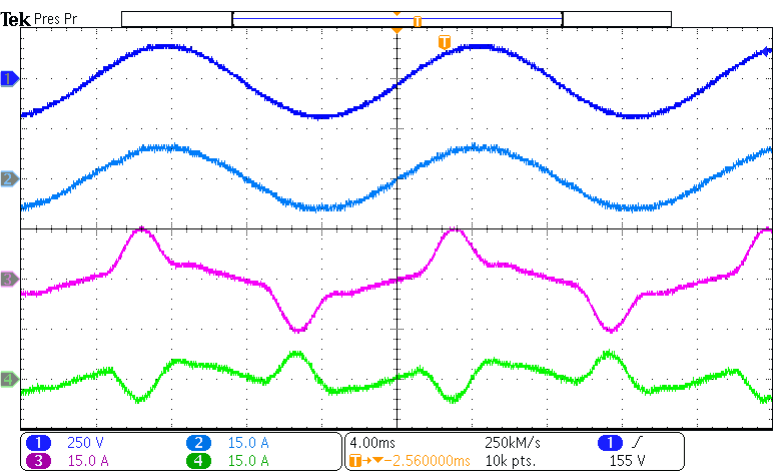
Figure 11. Steady state responses at the PCC after the current compensation process of: (CH1) the voltage v PCC (y-axis 250 V/div); (CH2) the grid current i G (y-axis 15 A/div); (CH3) the current consumed by the NLL i NLL (y-axis 15 A/div); and the injected current i AF (y-axis 15 A/div, x-axis 4